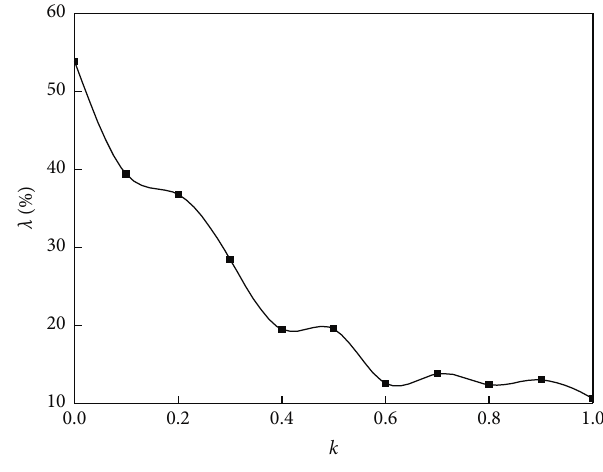
Figure 15: The variation of λ with k .